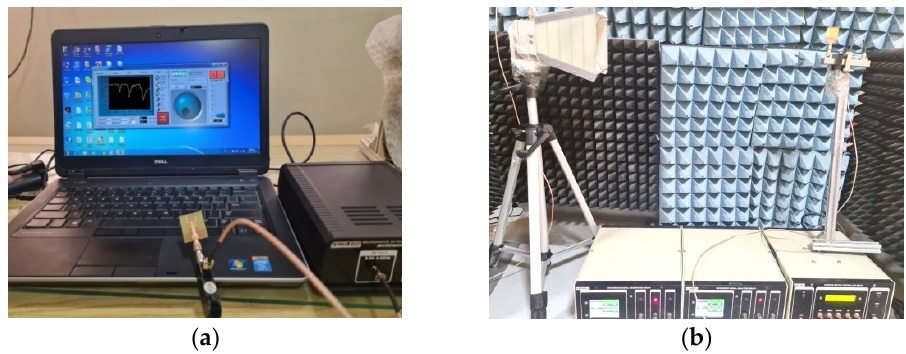
Figure 10. The measurement setup of ( a ) the reflection coefficient curve and ( b ) the radiation pattern and gain.